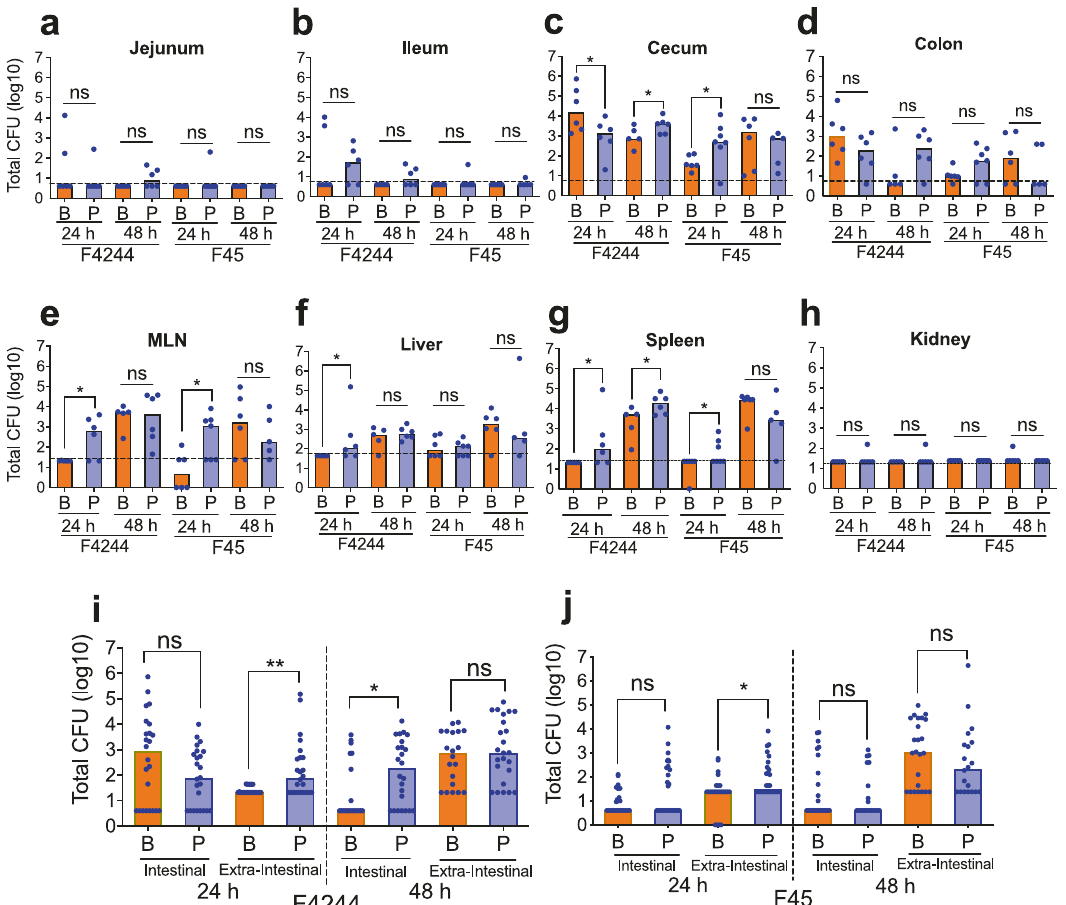
Fig. 5 Mouse bioassay to compare the pathogenesis of bio fi lm-isolated sessile and planktonic L. monocytogenes cells. Lm burden in intestinal ( a – d ) and extra-intestinal tissues ( e – h ) after oral inoculation of mice (C57BL/6, male – female, 8 – 10 weeks old) with 1 × 10 9 CFU/ mouse of sessile (B) and planktonic (P) cells of F4244 or F45 at 24 and 48 hpi. i , j Comparison of the number of bacteria in all intestinal and extra-intestinal tissues at 24 and 48 hpi. Bars represent the median values of each group (B or P). Dashed lines indicate detection limits by a plating method. Mann – Whitney test was used for statistical analysis. ** P < 0.005; * P <